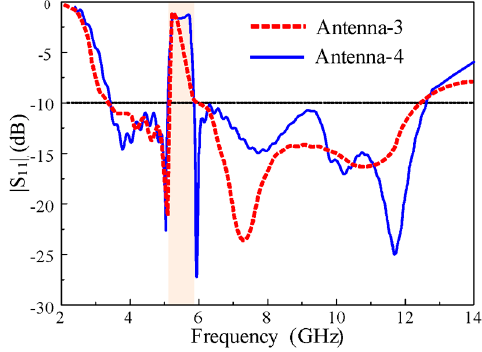
Figure 7. Characteristics of Antenna-2 and antenna design procedure to achieve conventional notched UWB patch antenna.